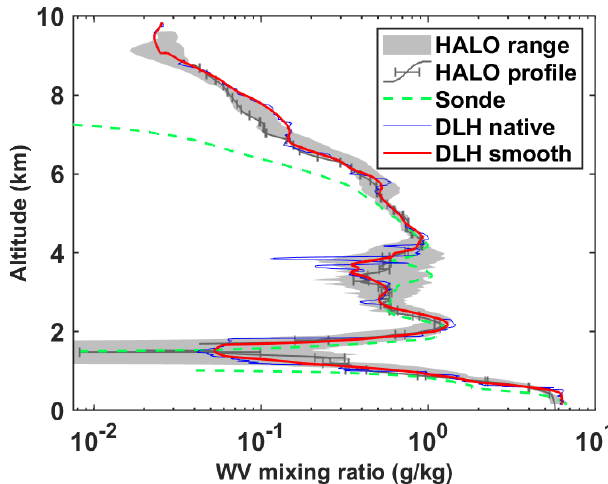
Figure 7. HALO comparisons to DLH and sonde from the descent on 30 April. The blue line is the DLH data at native resolution. The red line is DLH smoothed with a 315m rolling average to match the constant 315m vertical resolution of the HALO profile. The gray area shows the range of HALO measurements in the area of the spiral descent from the preceding overpass, indicating the ex- pected spatiotemporal variability of the region. An example HALO profile from right before the descent is also shown, with bars de- noting measurement statistical uncertainty. The dashed green line shows the malfunctioning sonde profile. Table 2. Statistics of HALO comparisons with other instrumen- tation. DLH comparison is against the average of the closest five HALO measurements. AIRS and IASI comparisons are of PWV, as shown in Fig. 11. n is the number of data points in the comparison. n Bias R 2 (HALO – x